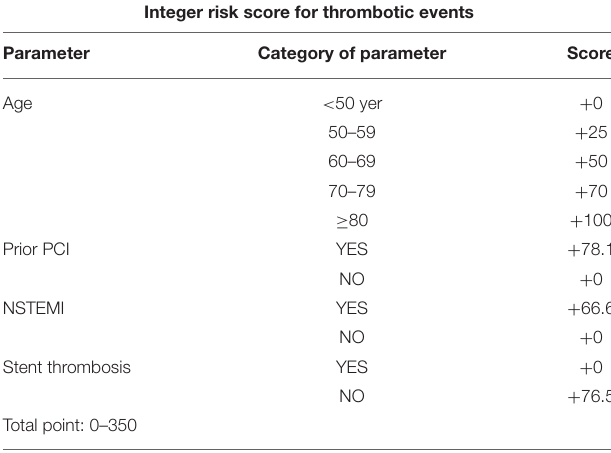
TABLE 3.2 | Integer risk score for thrombotic